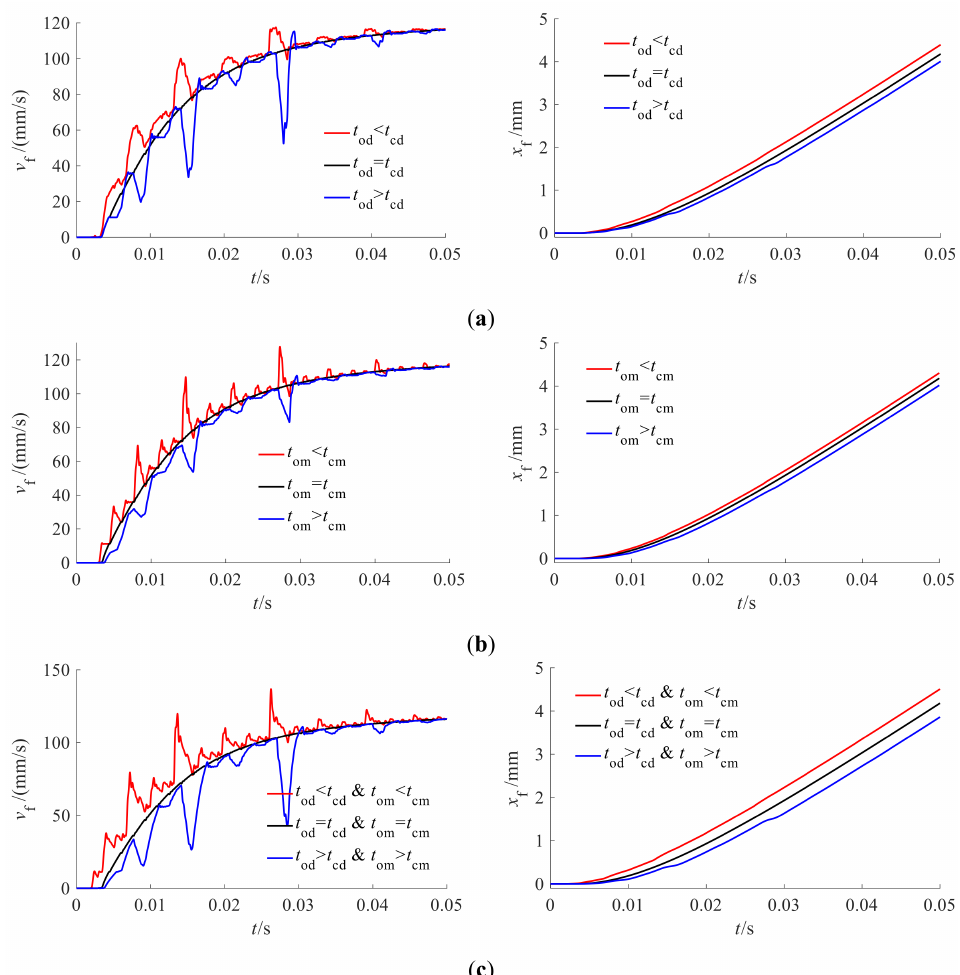
Figure 7. Effects of the asymmetry of the dynamic time of the BDVA on the moving characteris- tics of the fuel metering valve: ( a ) Asymmetry of delay time; ( b ) Asymmetry of movement time; ( c ) Asymmetry of delay time and movement time. Left: velocity, Right: